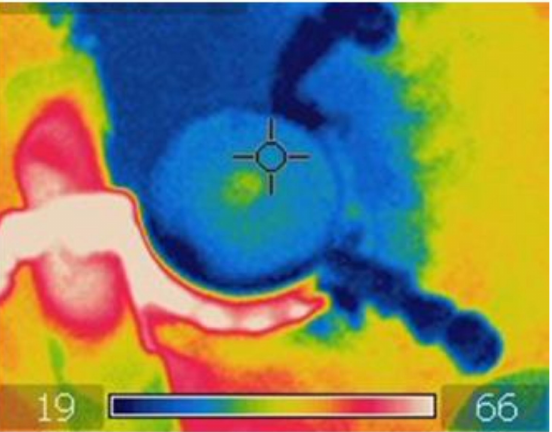
Figure 1. Operational prototype of the thermomagnetic heat engine.